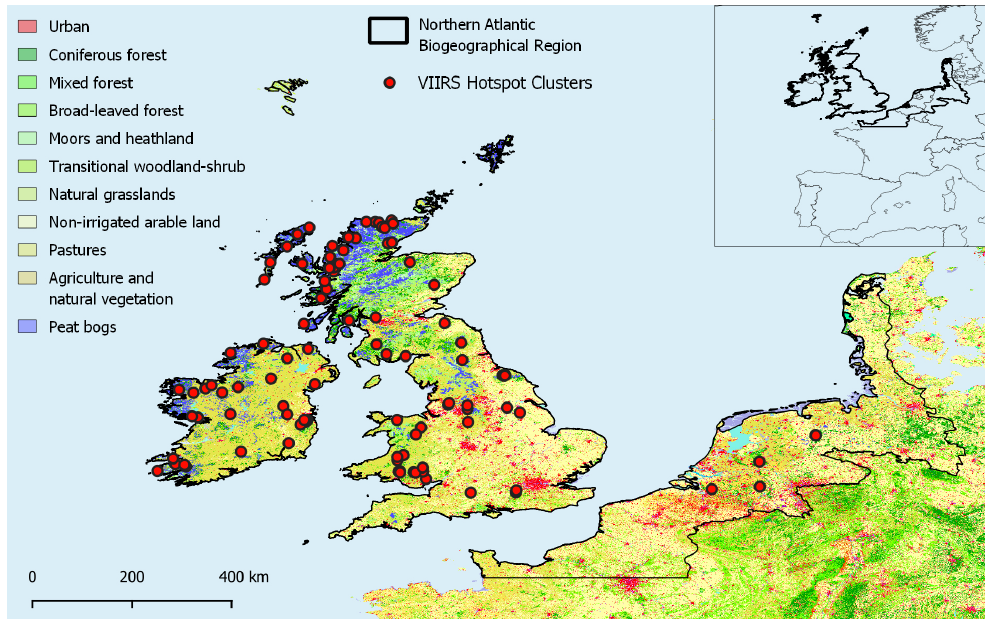
Figure 1. Study area of northwest Europe, encompassing the United Kingdom, Ireland, the Netherlands, Belgium, Denmark, northern France, and northwest Germany within the northern Atlantic biogeographical region above the 49th parallel (Sundseth et al., 2009). Locations of the fire hotspot clusters generated from VIIRS 375m active fire product (VNP14IMGTDL_NRT; https://firms.modaps.eosdis.nasa.gov/ download/, last access: January 2022) derived from 326935 hotspot detections from January 2012 through June 2022. Land cover data source: Copernicus Land Monitoring Service’s Corine Land Cover Map 2018 (European Union,